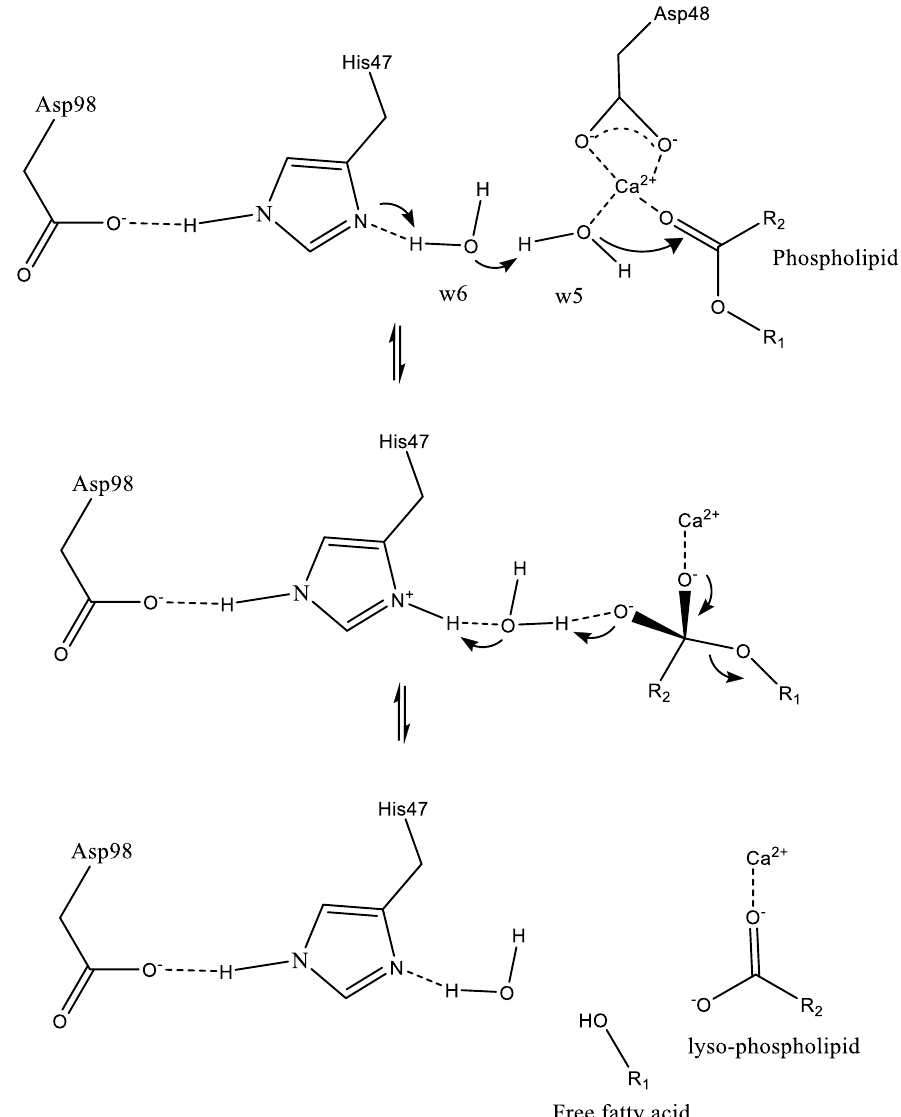
Figure 4. Proposed catalytic mechanism for sPLA2. Asp98 and His47 constitute the catalytic dyad which plays a key role in catalysis. These two residues are hydrogen-bonded together and further connected with the Ca 2+ ion with the help of two water molecules (w5 and w6). His47 facilitates the deprotonation of w5 water molecule, subsequently attacks the sn-2 carbonyl group of the substrate and forms the tetrahedral intermediate. The rate-limiting step is the decomposition of the tetrahedral intermediate